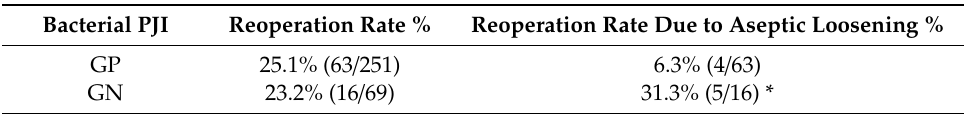
Table 1. Analysis of reoperation rates due to aseptic loosening in patients with periprosthetic joint infection ( n = 320) caused by Gram-positive versus Gram-negative bacteria.